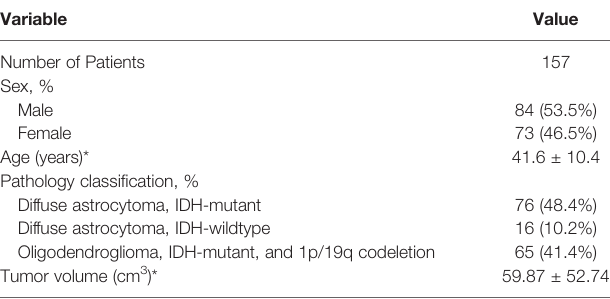
TABLE 1 | Baseline demographics and clinical characteristics of patients. Variable